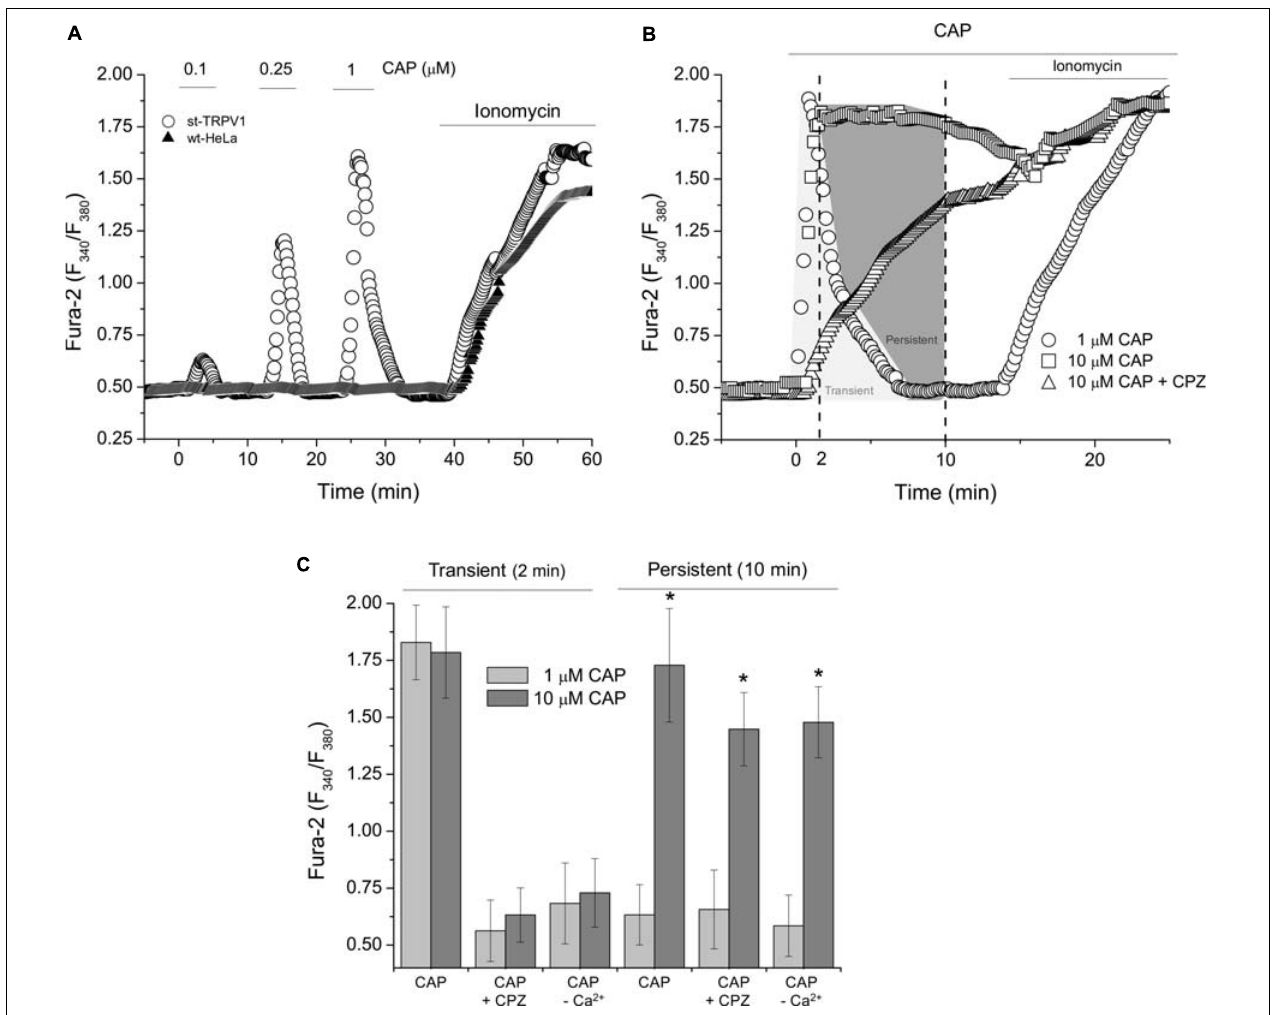
FIGURE 4 | TRPV1 expression increases intracellular calcium level in response to CAP. (A) Dose–response curve of ratiometric assay recordings for [Ca 2 + ] I in wt-HeLa cells and st-TRPV1 HeLa cells exposed to 0.1, 0.25, and 1 µ M CAP for 60 min. Representative experiments from five independent experiments. (B) Dose–response curve of ratiometric assay recordings for [Ca 2 + ] I in st-TRPV1 HeLa cells exposed to 1 and 10 µ M CAP in the presence or absence of 10 µ M CPZ for 20 min. Representative experiments from five independent experiments. 10 µ M ionomycin was added at the end of experiments (A) and (B) as positive control. (C) Cross-sectional ratiometric [Ca 2 + ] I in st-TRPV1 HeLa cells exposed to 1 and 10 µ M CAP at times 2 and 10 min after CAP exposition, in the presence or absence of 10 µ M CPZ or Ca 2 + -free condition. Data are shown as mean ± SEM ( n = 15). ∗ p <